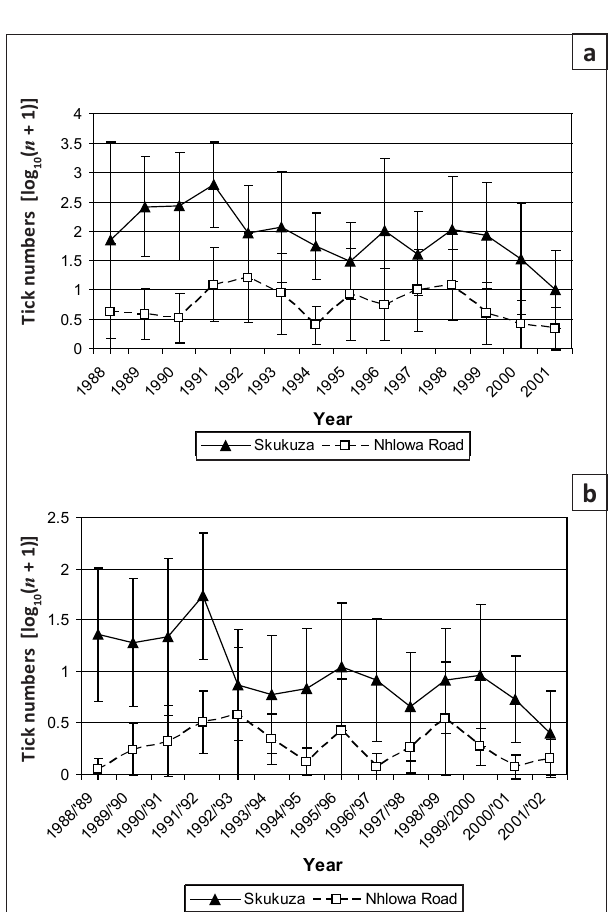
( n + 1)] by habitat. 10